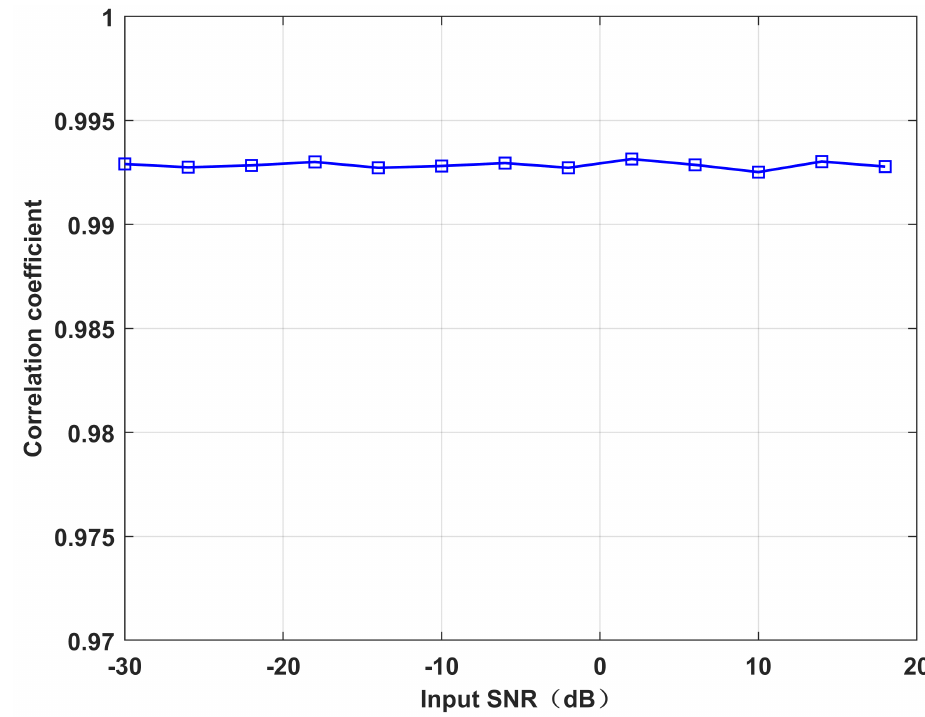
Figure 1. Correlation coefficient versus input